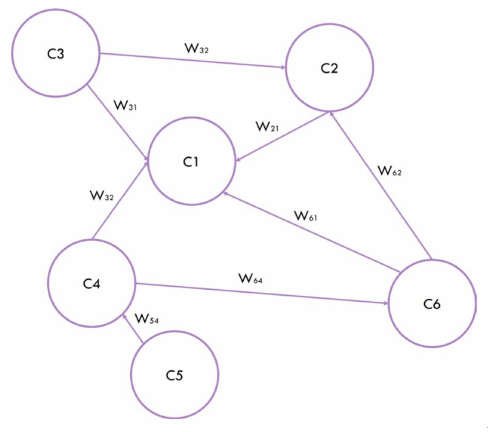
Figure 2. Graph display of a fuzzy cognitive